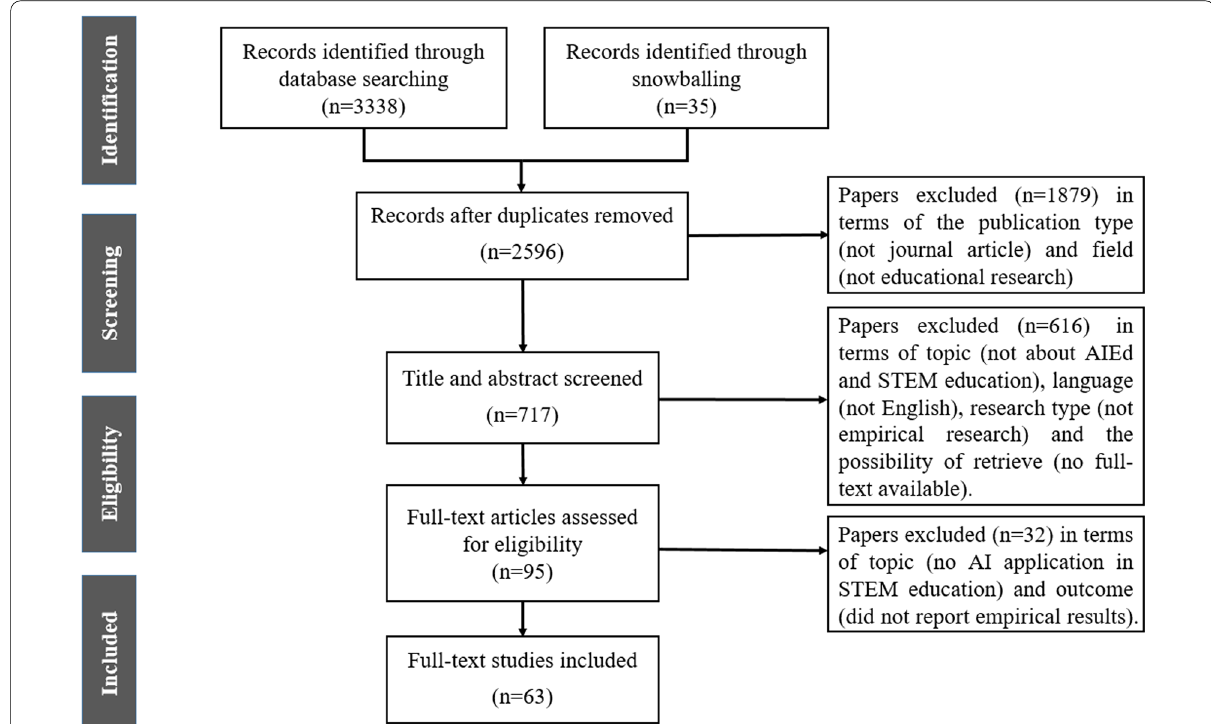
Fig. 3 The integration of technology in an educational system from the GST